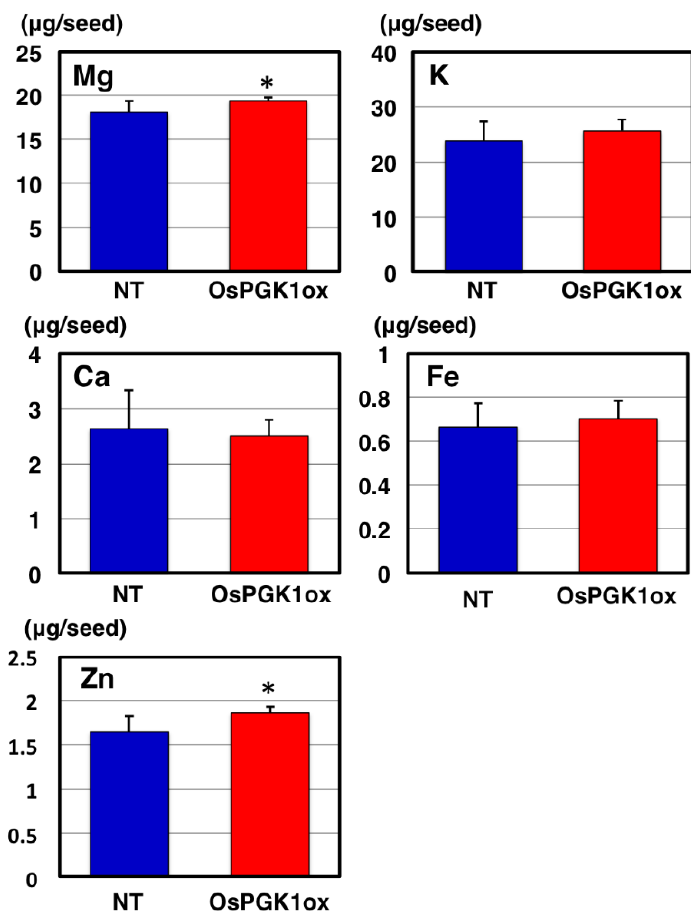
Figure 5. Contents of Mg, K, Ca, Fe, and Zn in mature seeds of OsPGK1ox and